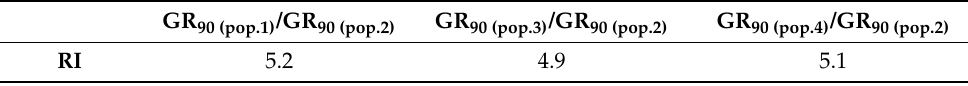
Table 4. Resistance indices for populations 1, 3 and 4, calculated as the ratio of the GR 90 of the considered R populations (pop.1, 3, 4) to the GR 90 of the considered S population (pop.2).